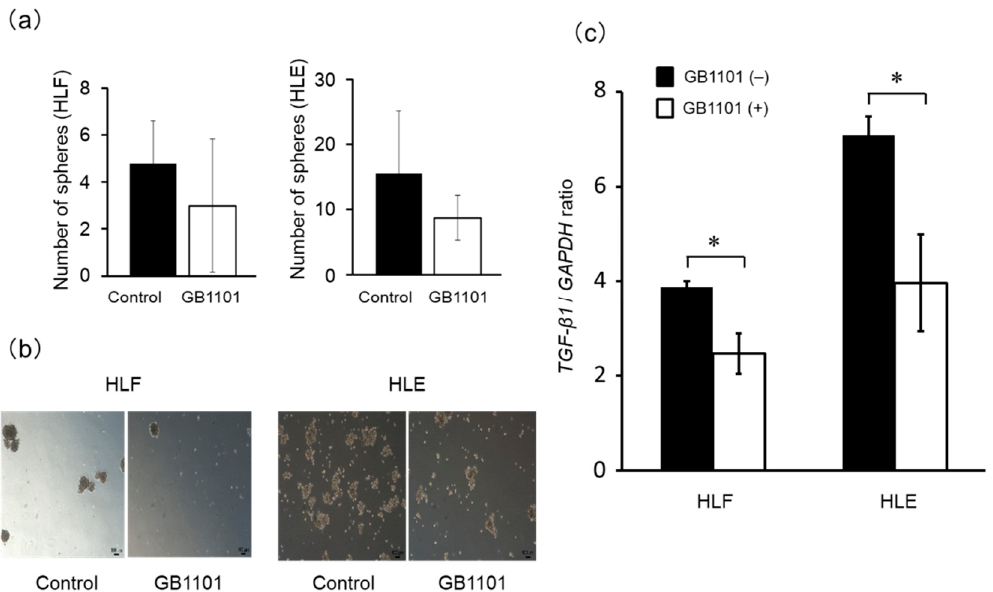
Figure 4. Effect of GB1101 on sphere formation of human HLF and HLE cells, TGF- β 1 expression of liver cancer cells. HLF and HLE cells in suspension were incubated in the absence or presence of 1 µ M GB1101 for 7 days. The number of spheres formed in the suspension culture medium was counted and the results are presented as the mean ± SD (n = 5) ( a ). At 7 days post-treatment, the cells were photographed ( b ) and TGF- β 1 mRNA expression ( c ) was assessed by qPCR and the data are presented as the mean ± SD (n = 3). *, p < 0.05.